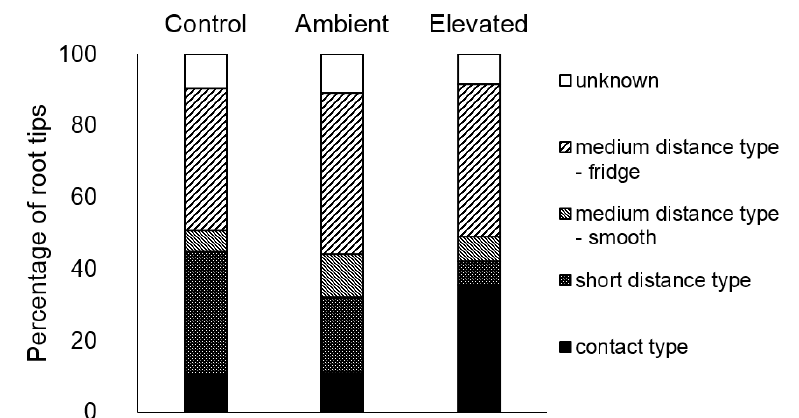
Figure 3. Ectomycorrhizal fungal exploration type abundance as a percentage of total Picea abies root tips colonised. The trees were grown in an unenclosed control or in glass domes at ambient CO 2 or elevated CO 2 levels at the Bílý Kříž site.